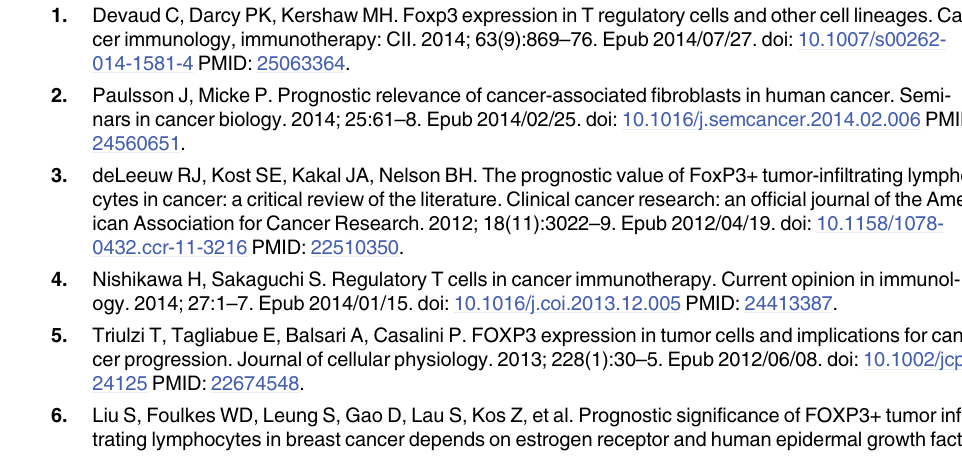
S1 Table. The NOS scores of the included studies. (Note: Data given as the definite option of each item. ※ means that the score was